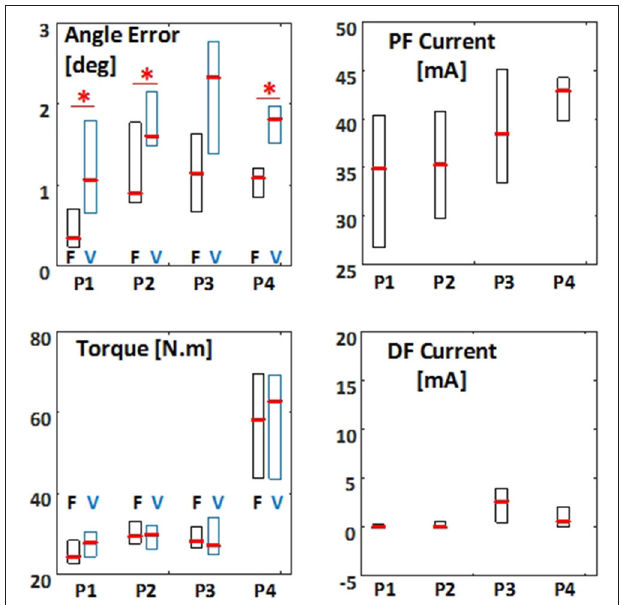
FIGURE 6 | The root mean square (RMS) of the error between the pendulum angle and reference angle, applied torque, and applied FES pulse current amplitude to plantarflexors (PF) and dorsiflexors (DF) for different test paradigms. F indicates FES controlled balance, and V indicates disrupted voluntary control of muscle contractions. The results are presented as boxplot among all subjects, for all test paradigms (indicated with P1–P4). Boxplots related to FES condition are shown is black and those related to VOL condition are shown in blue. Asterisk indicates significant difference ( p < 0.05) between FES and VOL conditions.